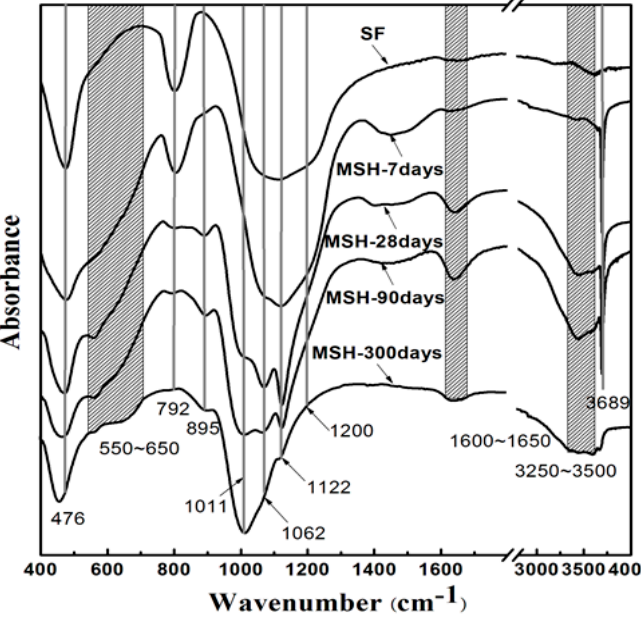
Figure 8. Fourier transform-infrared (FT-IR) spectra of the MSH samples and silica fume.